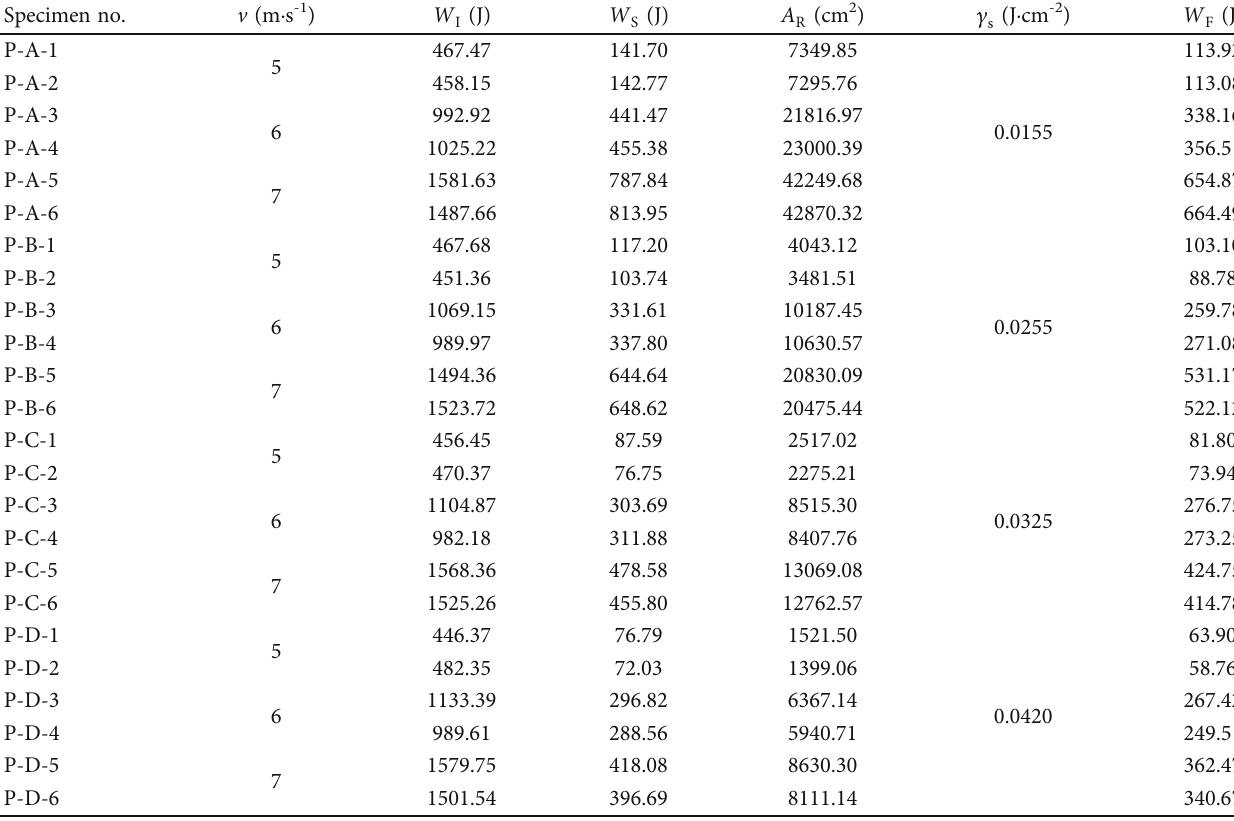
Table 3: Calculation results of relevant energy during impact compression of concrete specimens. Specimen